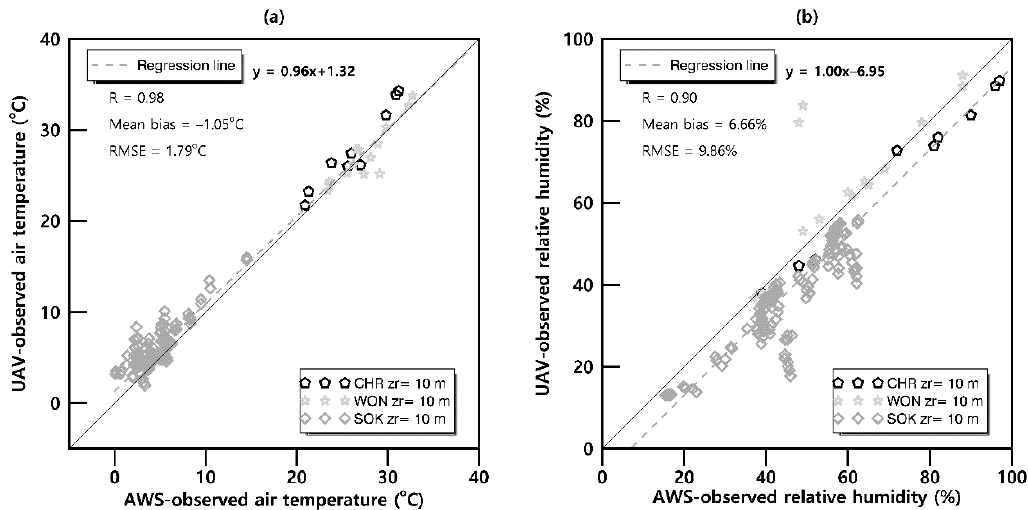
Figure 3. Comparison of UAV-observed air temperature ( a ) and relative humidity ( b ) with corresponding automatic weather system (AWS)-observed air temperature and relative humidity at 10 m.